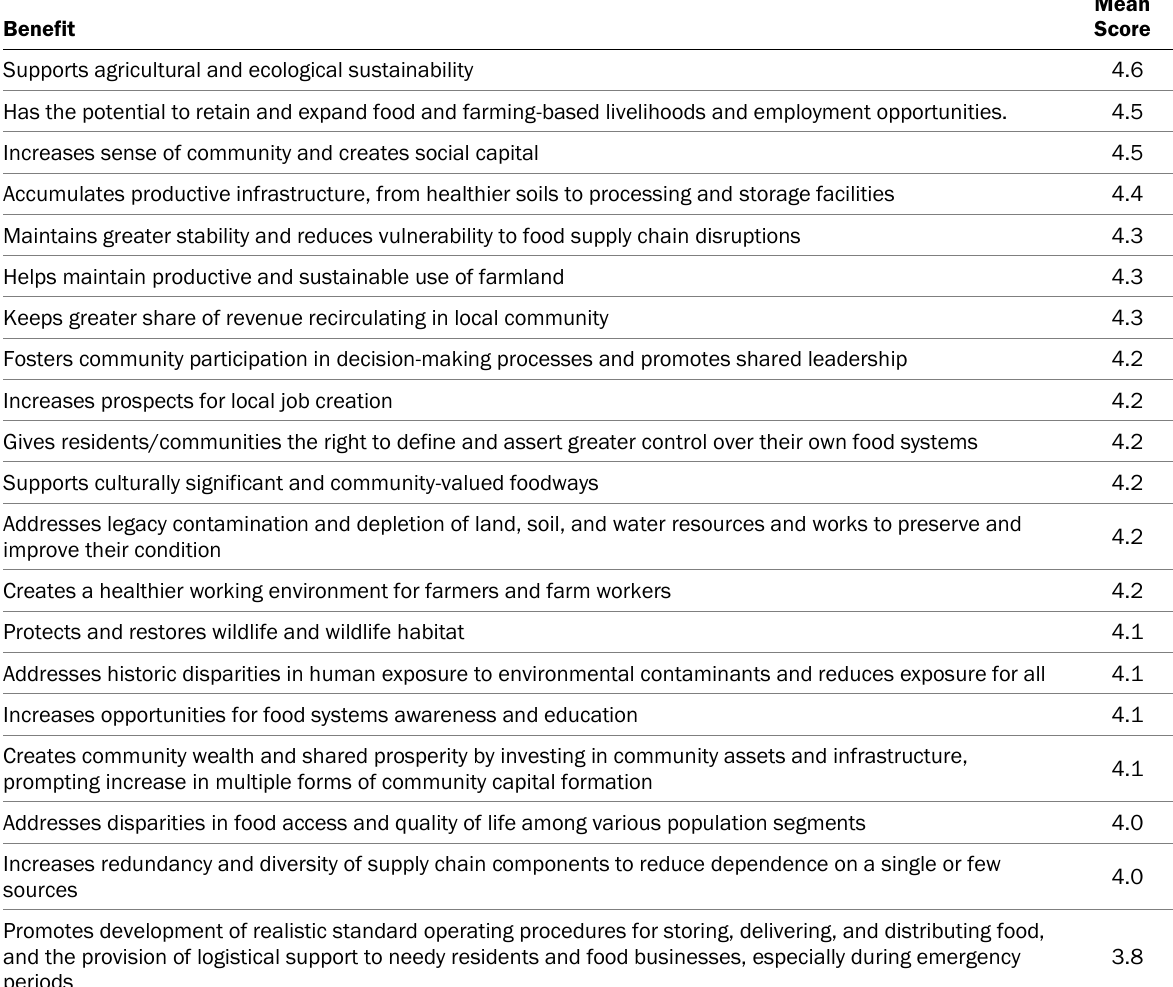
Table 3. Perceived Benefits of Adopting Community Food Systems Resilience Policies and Programs